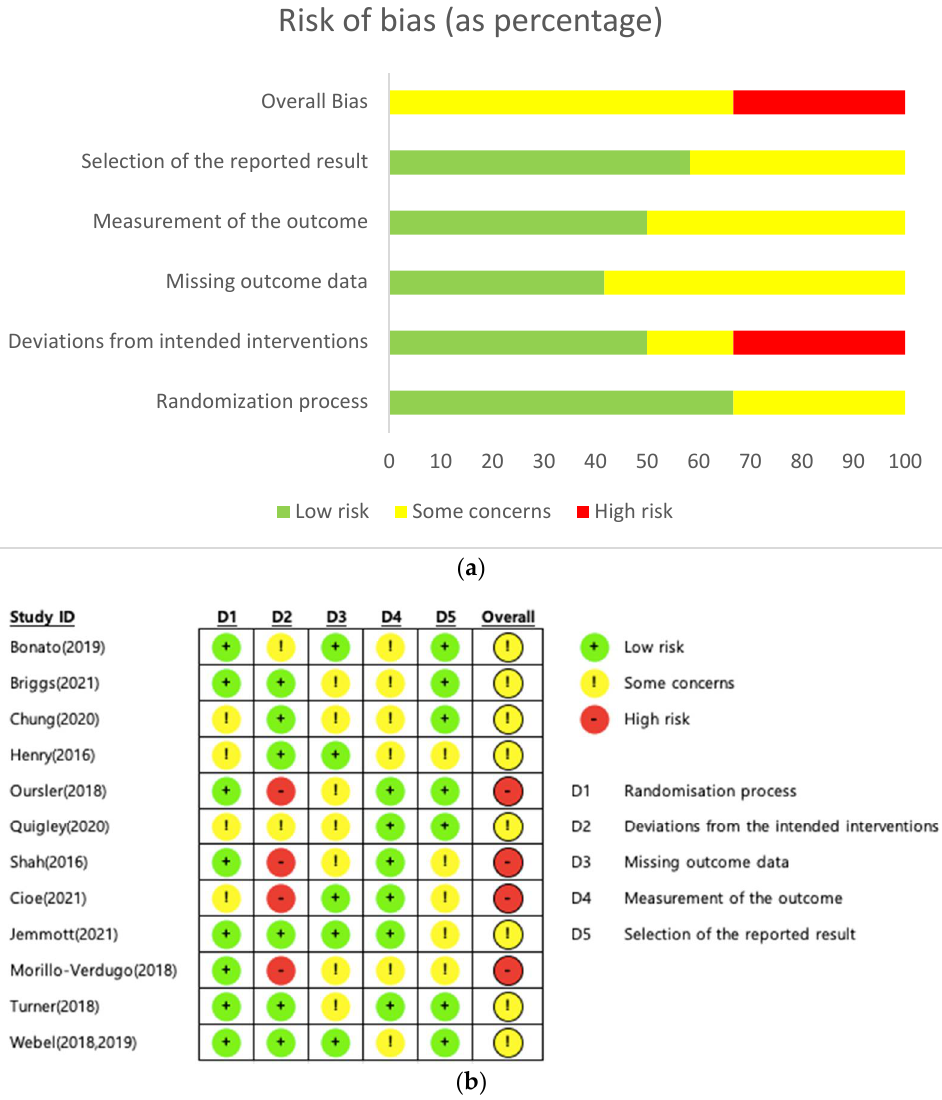
Figure 2. Risk-of-bias graphs for the studies included for the meta-analysis and systematic review. ( a ) Risk-of-bias as a percentage; ( b ) risk-of-bias summary [16–19,27,33–40].